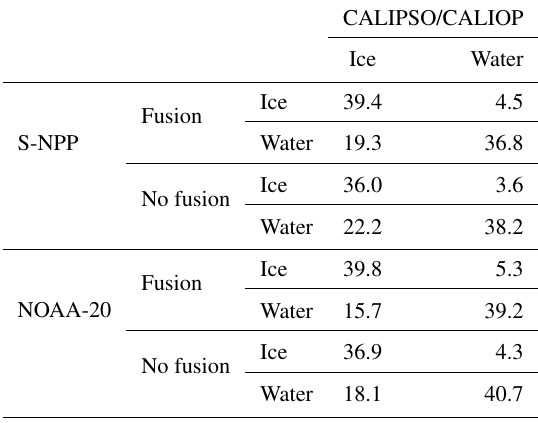
Table 3. Percentages (%) of global cloud-phase detection when a valid cloud top height (CTH) retrieval is available comparing CALIPSO/CALIOP and CLAVR-x S-NPP VIIRS under both fusion and no-fusion